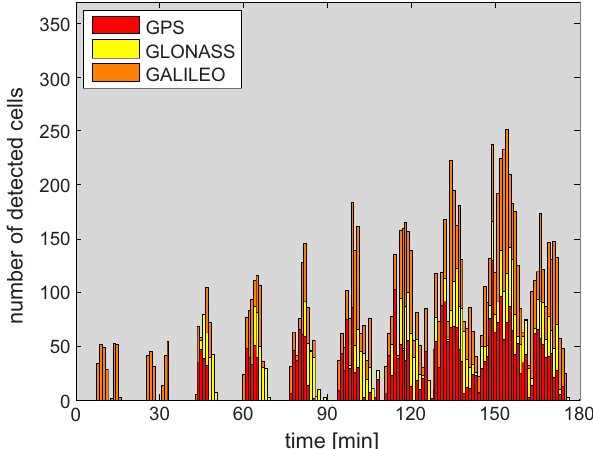
Fig. 7. Detection series for a Sumatra tsunami detection simu- lation with a LEO GNSS-R 18/3 Walker constellation at 900km with 60 ◦ inclination angle and GPS, GLONASS and Galileo as sig- nal sources. The figure shows a periodicity of detections due to the series of LEO satellites along the same orbit passing over the tsunami region. The number of detections increases with time be- cause the tsunami region increases and therefore the probability that a reflection ground track is passing through it. After 150min the number of detections decreases because the overall wave height de- creases and starts to drop below the assumed altimetric sensitivity limit.